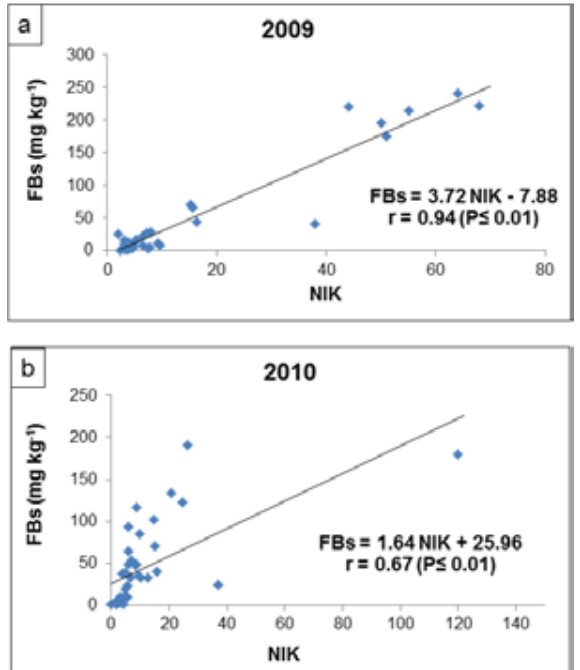
Figure 4. Scatter plots associating fumonisin concentration (FBs mg kg -1 ) vs Number of Infected Kernels (NIK) for the 40 inbred maize lines inoculated with F. verticillioides at CRA-MAC in 2009 (a) and 2010